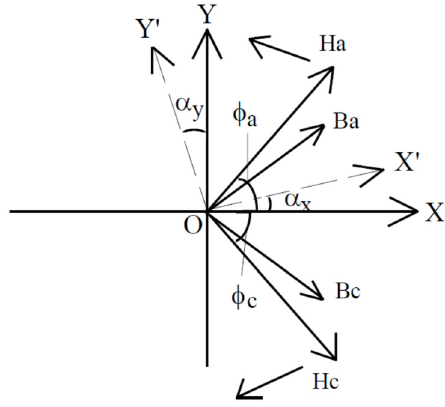
Figure 4. B and its correspondent H in two